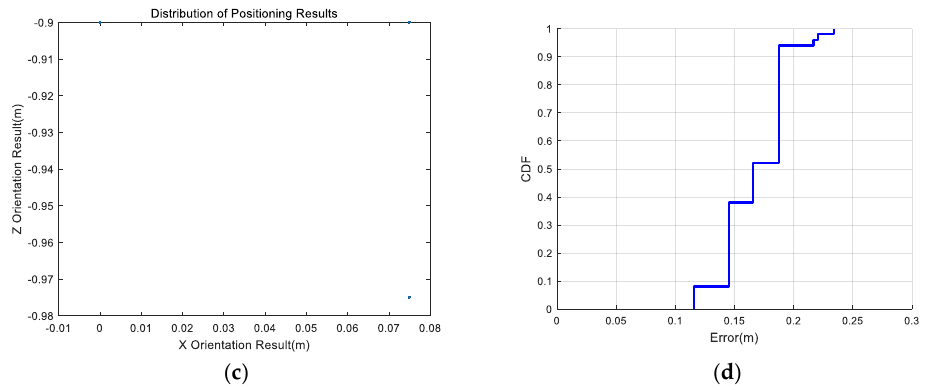
Figure 7. The static test location results for the source location of (0, −1). ( a ) Average error in the x– direction. ( b ) Average error in the z–direction. ( c ) Location distribution. ( d ) CDF.